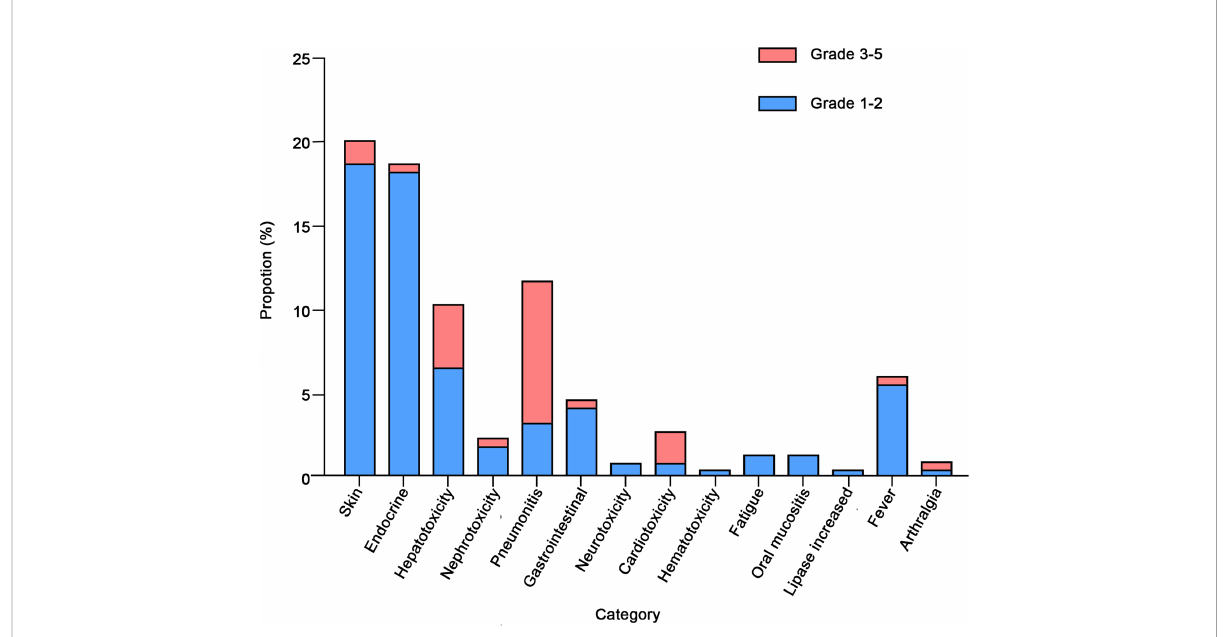
FIGURE 1 Category and grade of immune-related adverse events (irAEs) in non-small cell lung cancer